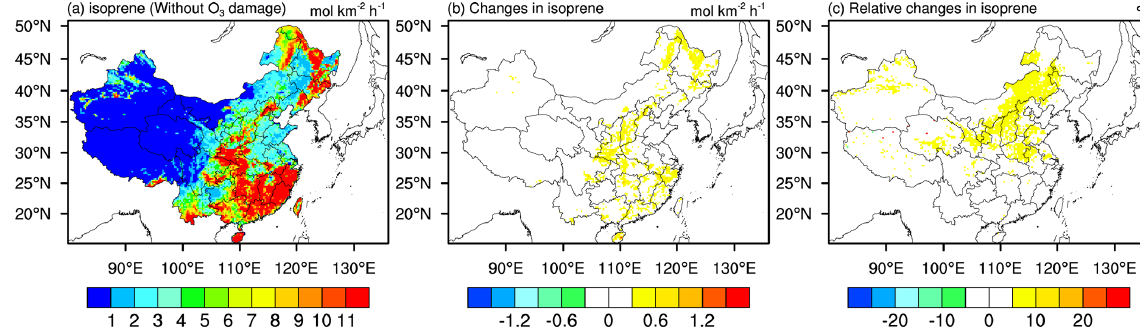
Figure 9. Same as Fig. 5 but for isoprene